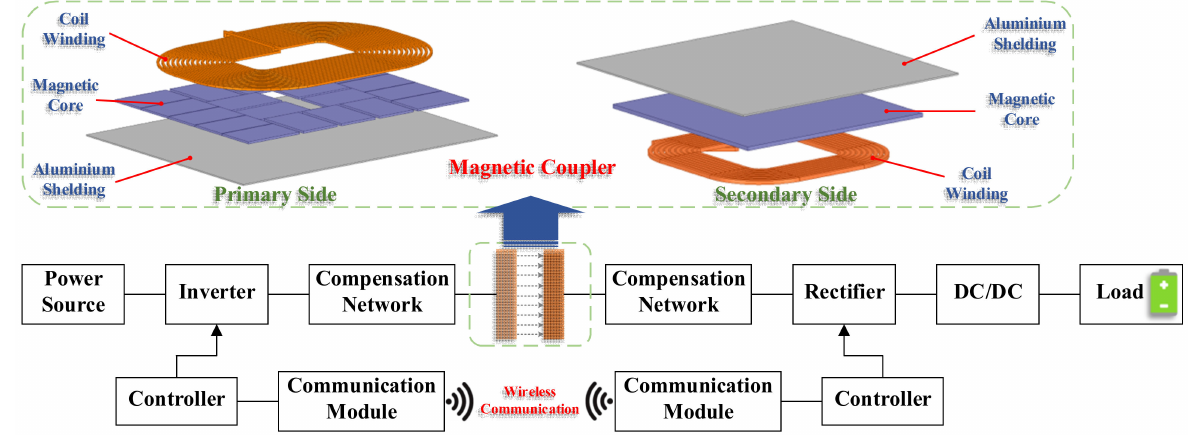
Figure 7. Composition of the MCR–WPT system and its magnetic coupler.